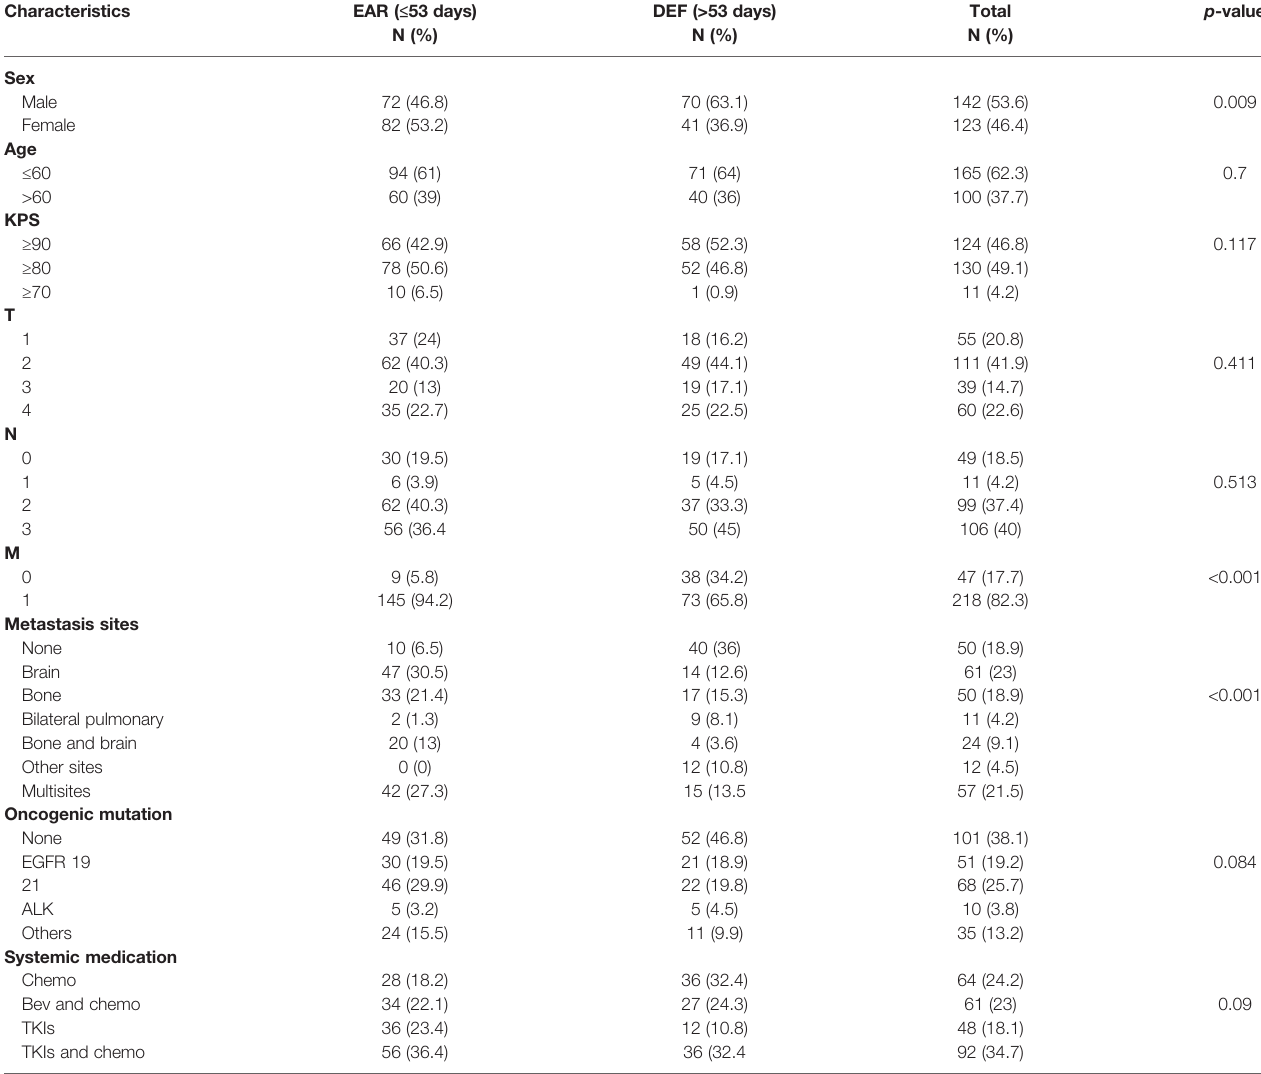
TABLE 1 | Baseline patient